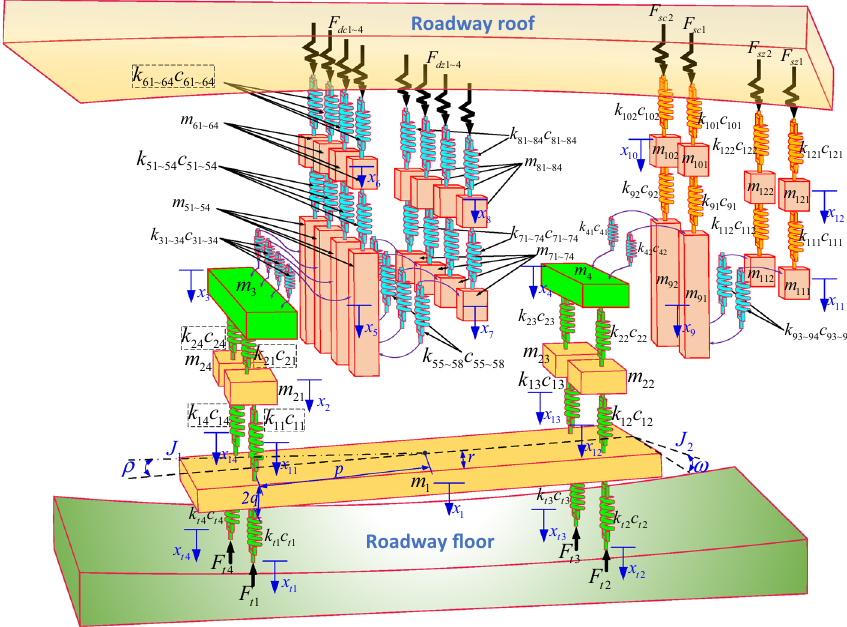
Figure 8. Construction of anchoring system dynamics